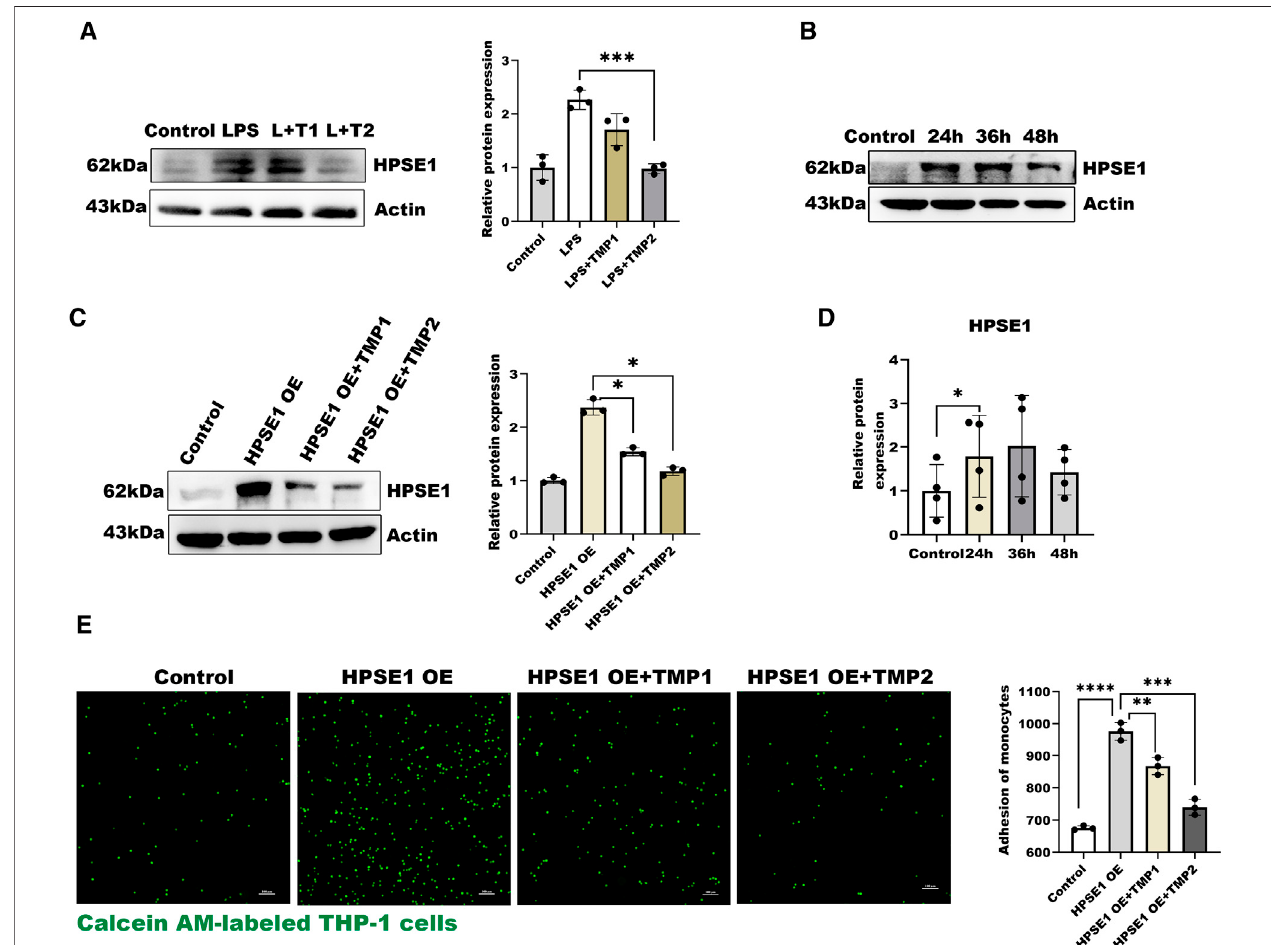
FIGURE3| EffectofTMPonHPSE1activation (A) WesternblotanalysisofHPSE1expressionafterTMPpretreatmentandLPStreatmentandquantitativeanalysis (B) Westernblotwasusedtoanalyzethetransfectionef fi ciencyofHPSE1at24,36and48 haftertransfection (C) PretreatmentofHUVECwithTMPfor12 hinhibitedthe expression of HPSE1 24 h (D) The protein bands of (B) were quantitatively analyzed by ImageJ (G) Monocyte adhesion assay was used to detect the adhesion of endothelial cells 24 h after overexpression of HPSE1. Bar: 100 μ m * p < 0.05. ** p < 0.005; *** p < 0.001.